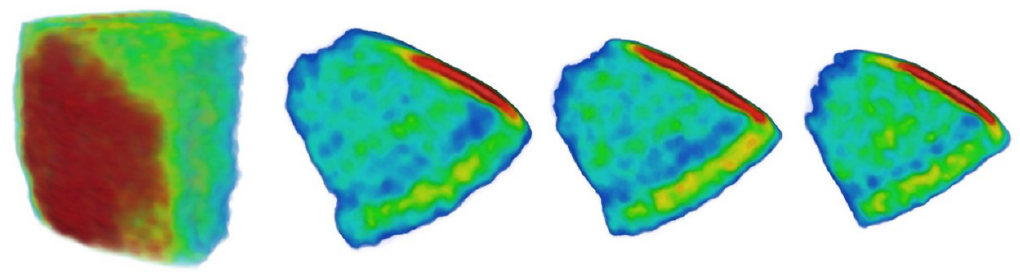
Figure 7. The reconstructed 3D model and several virtual slices of the mosaic fragment sample 5. It is assumed that the green areas correspond to the calcite phase, while the red regions are quartz areas. The rainbow‐like coloring shows neutron absorption degree from low (blue) to high (red).